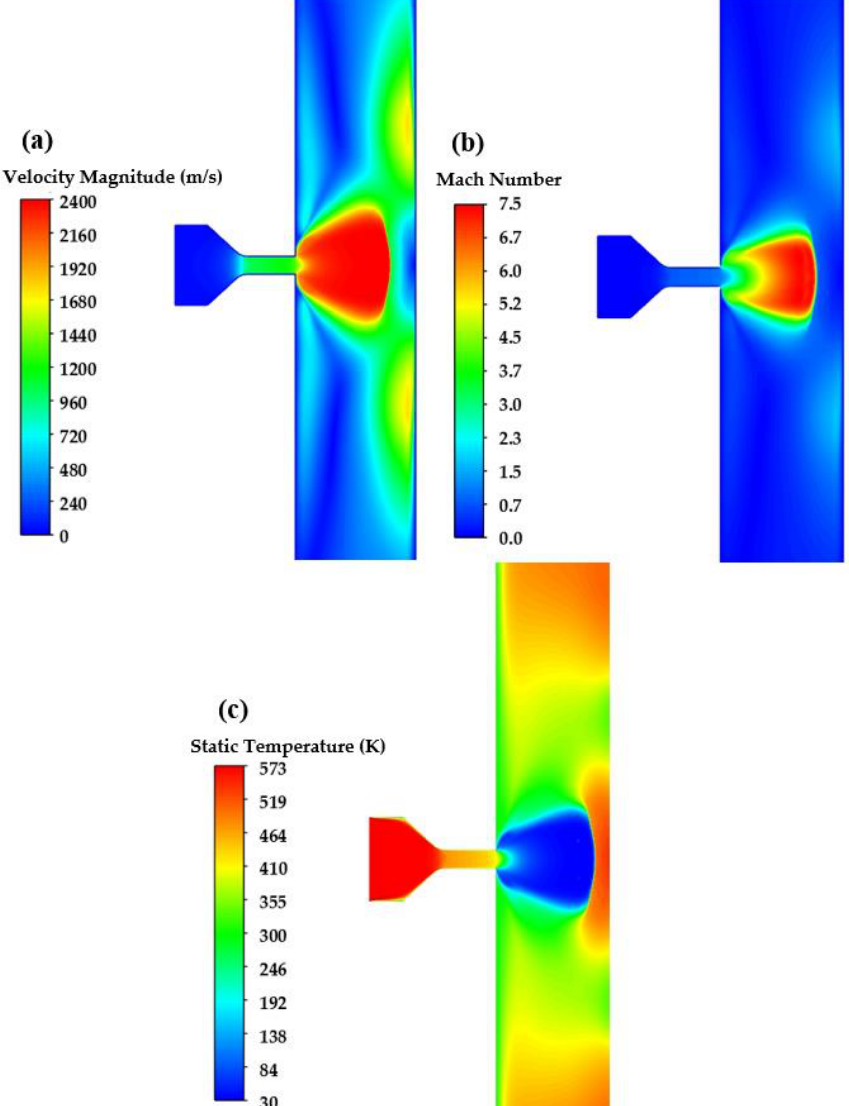
Figure 9. Contour of helium gas velocity ( a ), Mach number ( b ), and temperature ( c ) for a circular converging-barrel nozzle.